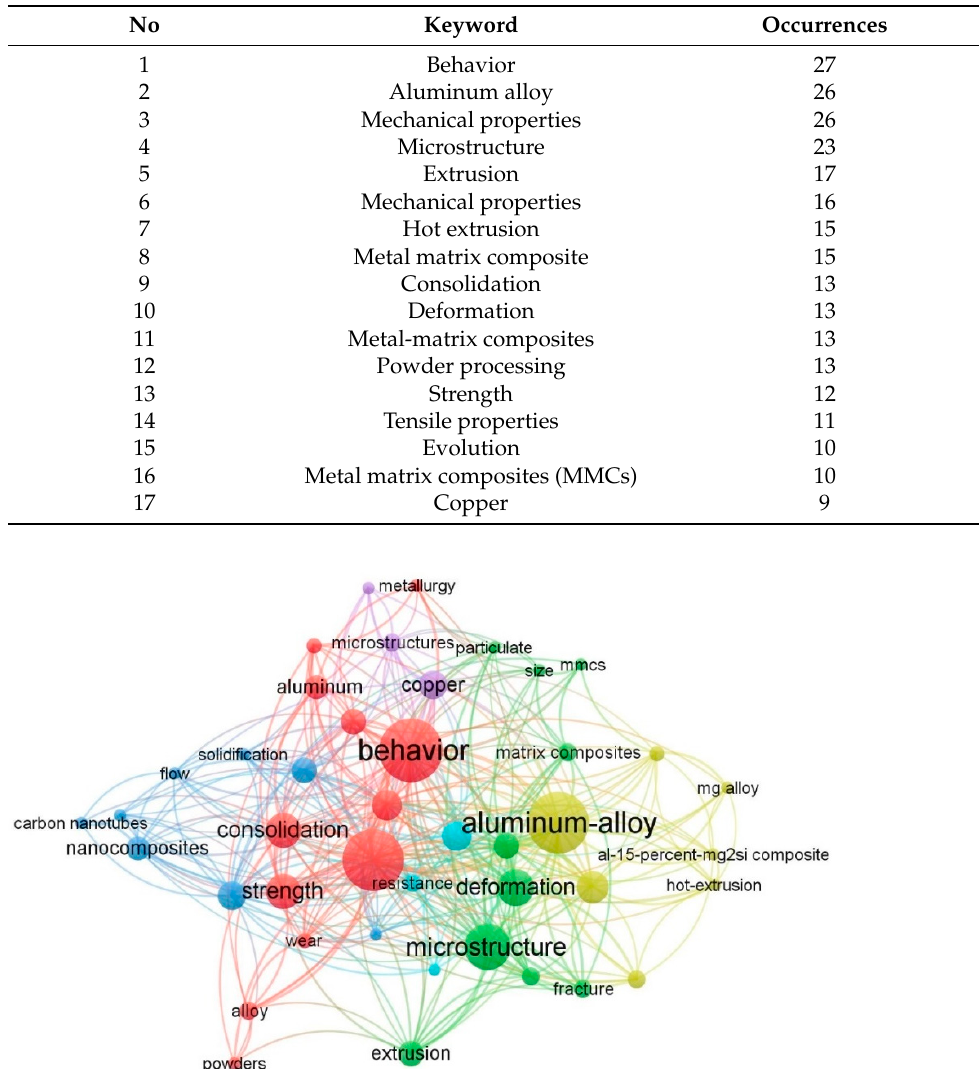
Figure 5. Keywords that emerged from the analysis.